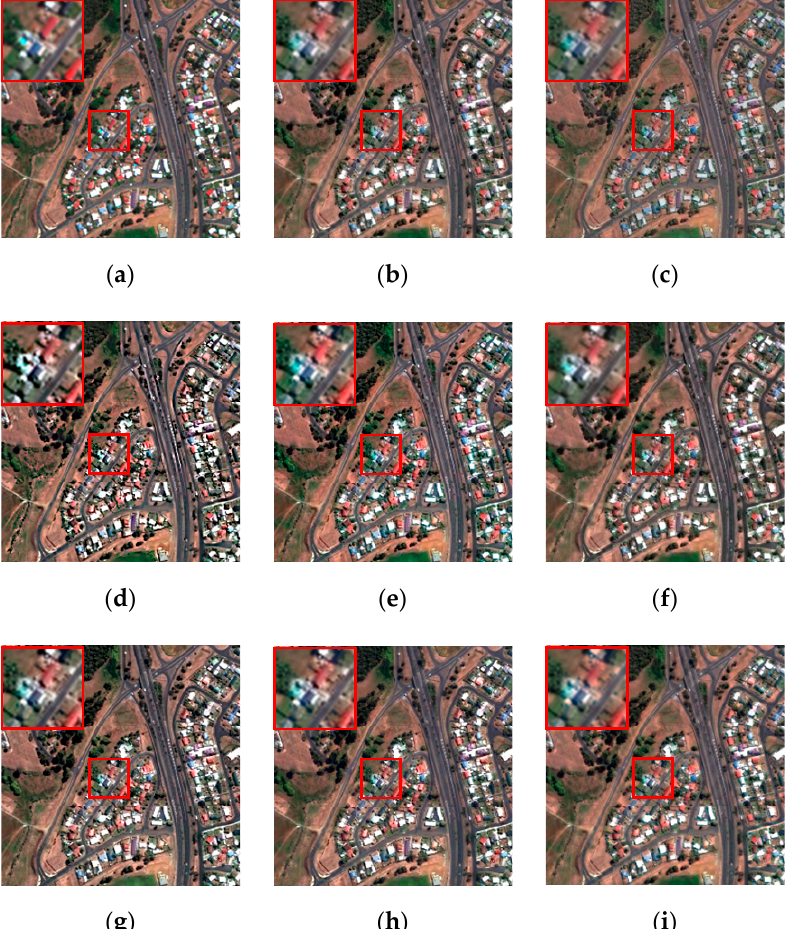
Figure 7. Fusion results of degraded data set from the GeoEye-1 satellite: ( a ) reference image; ( b ) à trous wavelet transform (ATWT); ( c ) Gram-Schmidt (GS); (d) MTF matched GLP with context-based decision (MTF-GLP-CBD); ( e ) band-dependent spatial detail (BDSD); ( f ) morphological filter-half gradients (MF-HG); ( g ) Gram–Schmidt adaptivebased on binary partition tree (GSA-BPT); ( h ) Gram–Schmidt adaptive with histogram-adjusted (GSA-HA); and ( i ) proposed method.